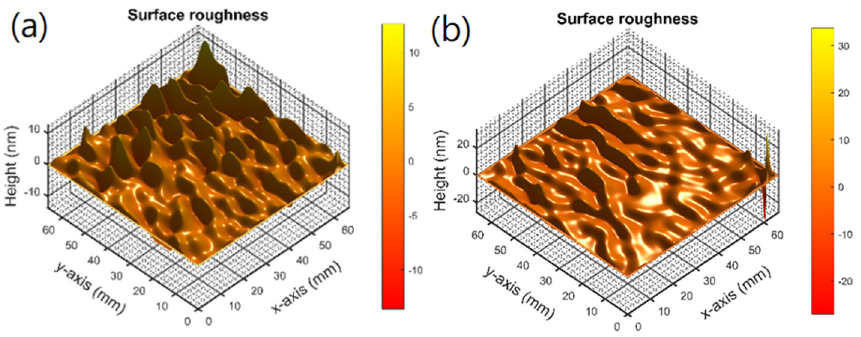
Figure 6. Surface roughness map of the sample measured by Linnik microscopic interferometer ( a ) before coating; ( b ) after coating.